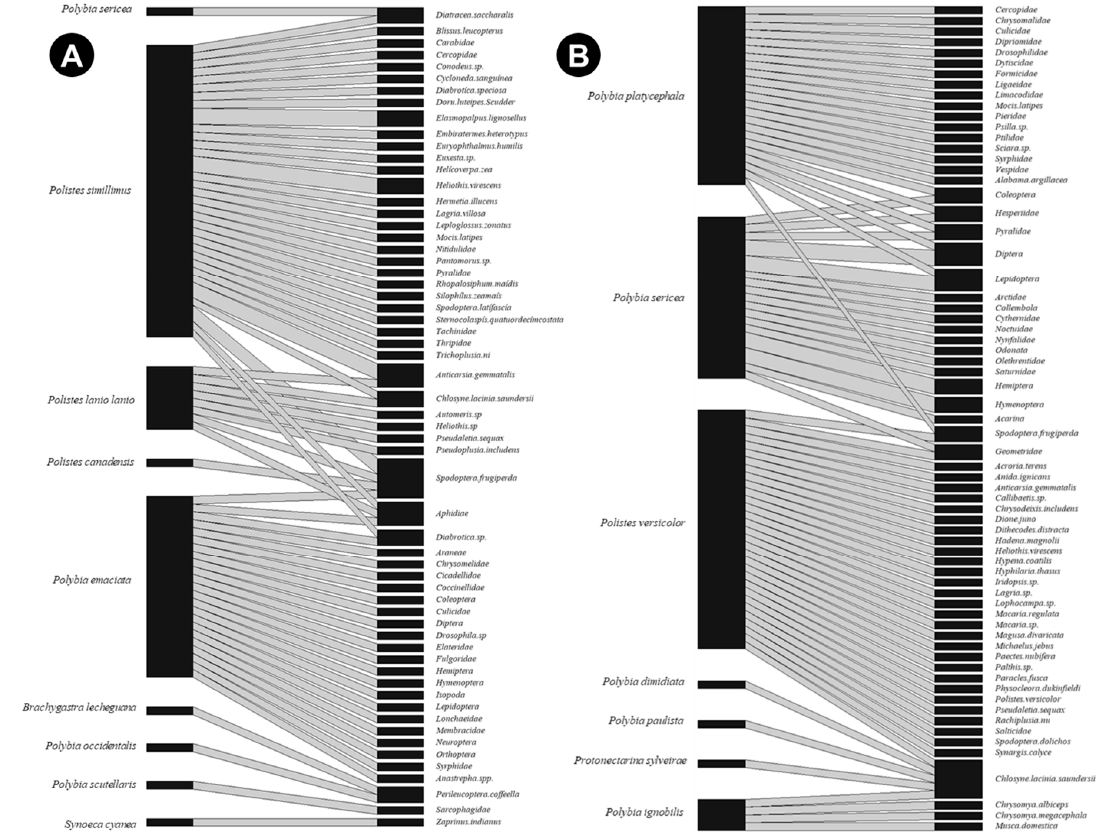
Figure 2. Ecological network between social wasps and their prey in small farms ( A ) and urban gardens ( B ). The left columns on each side represent social wasps, while the right columns represent captured prey. The height of each rectangle is directly proportional to the number of records made for the species, while links represent the number of records made between the pair of species.